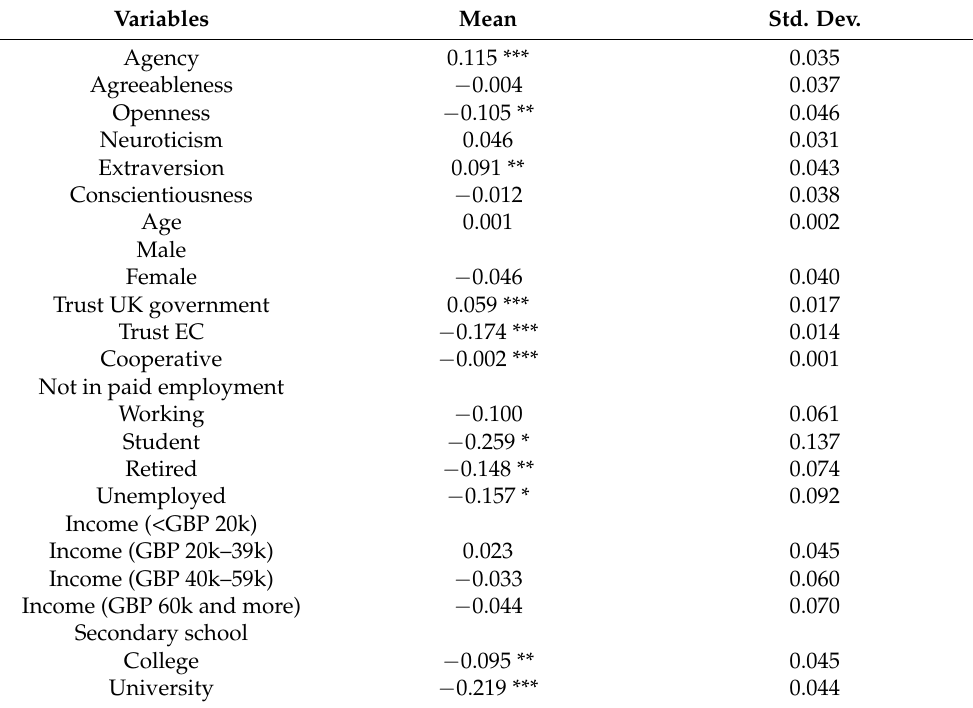
Table 4. Marginal effects of explanatory variables on the probability of voting for UK leaving the EU. Variables Mean Std. Dev. Agency 0.115